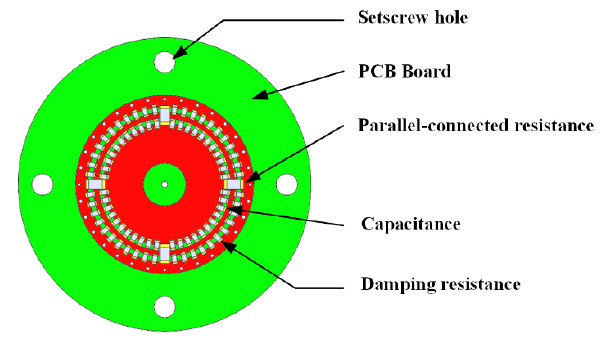
Figure 6. Structure of the low – voltage arm.